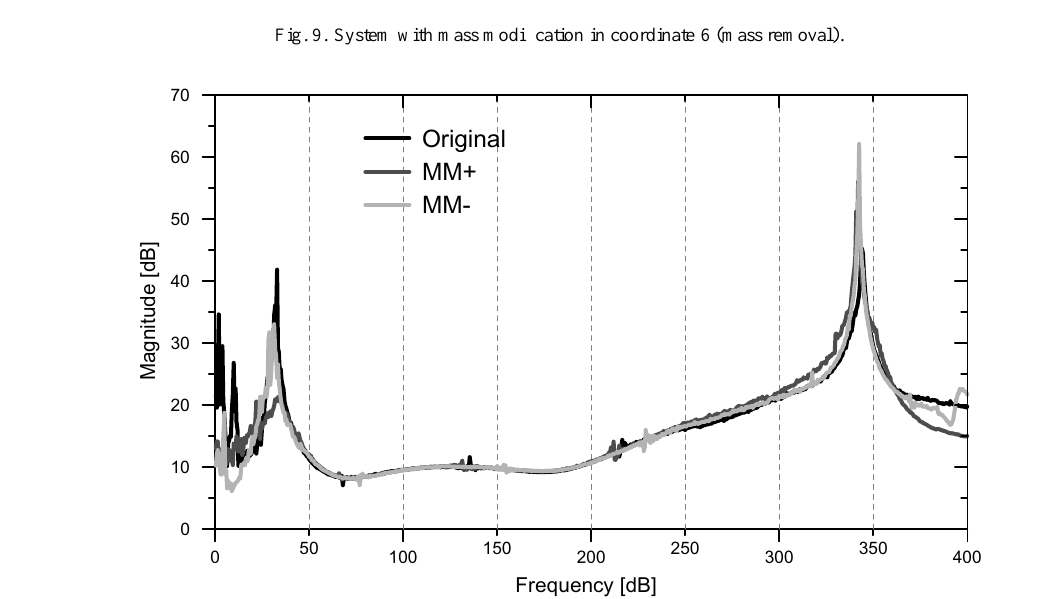
Fig. 10. Application of Transmissibility Indicator to the three case studies, original structure, MM+ and